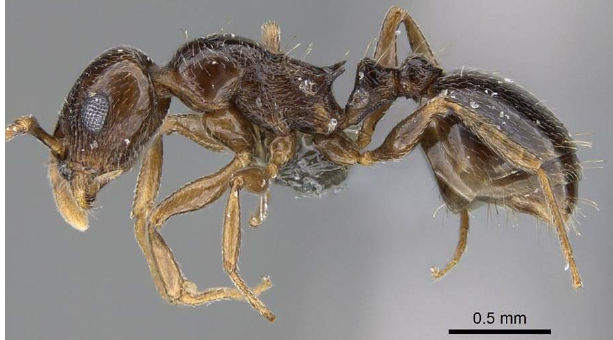
Fig 2 . Temnothorax ansei sp.n. worker in lateral view. Photo credit: Michele Esposito, from www.AntWeb.org ,CASENT0763775_P, published with